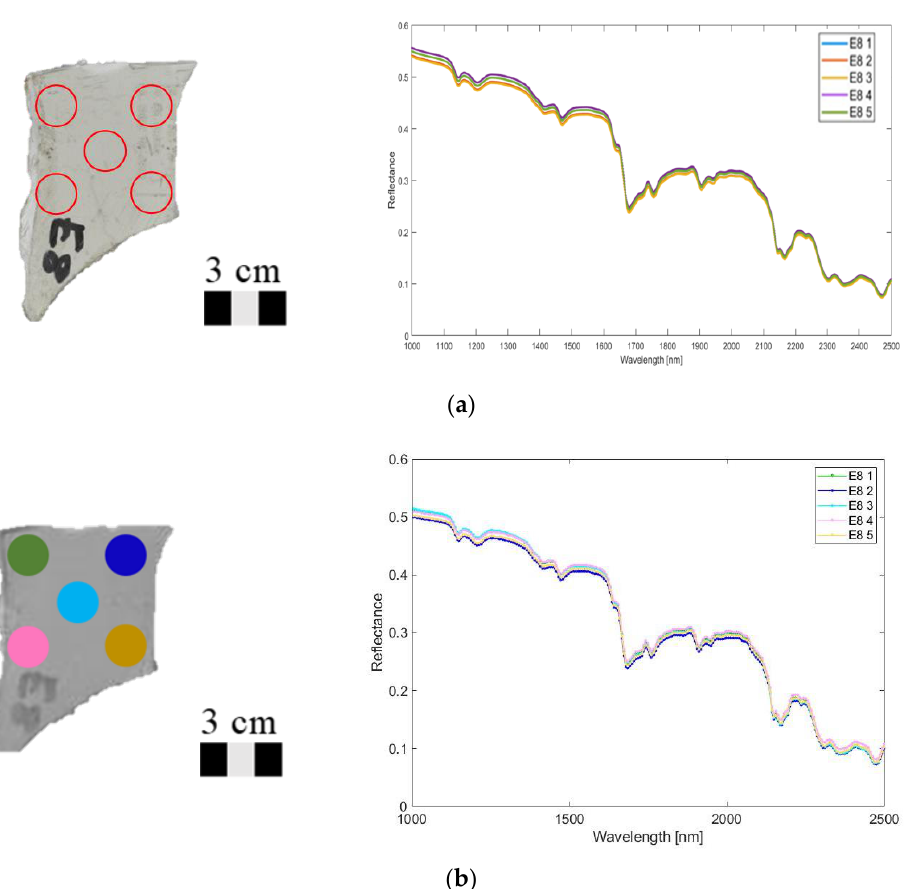
Figure 4. Topological assessment strategy, adopted for each plastic scrap, to select the five spectra acquisition points by ASD FieldSpec ® 4 Standard-Res and the resulting raw reflectance spectra (1000–2500 nm) ( a ) and the corresponding five Regions of interest (ROIs) utilized to collect raw reflectance spectra (1000–2500 nm) by the SisuCHEMA XL™ HSI system ( b ).